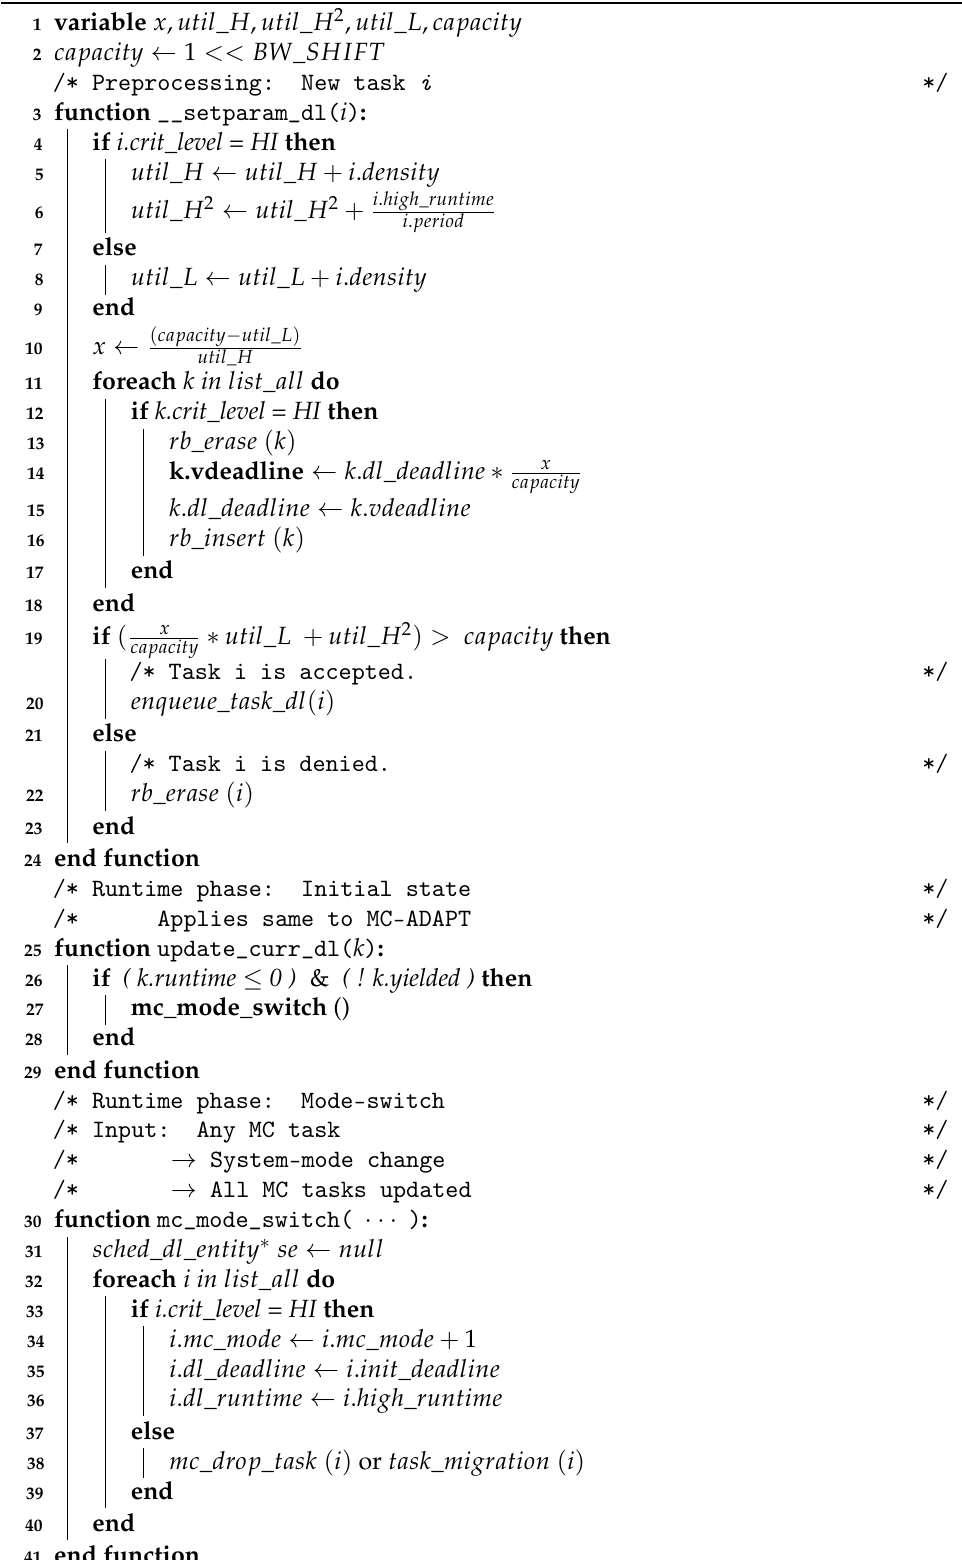
Algorithm 1: Linux EDF-VD